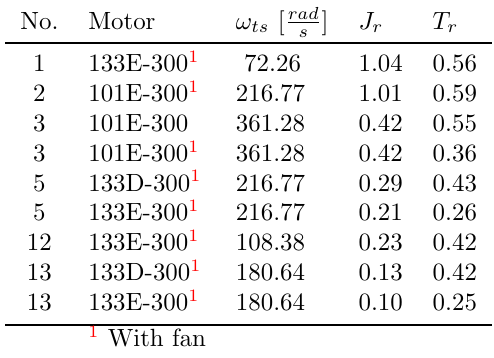
Table 4: EMC drivetrain pre-selection results.